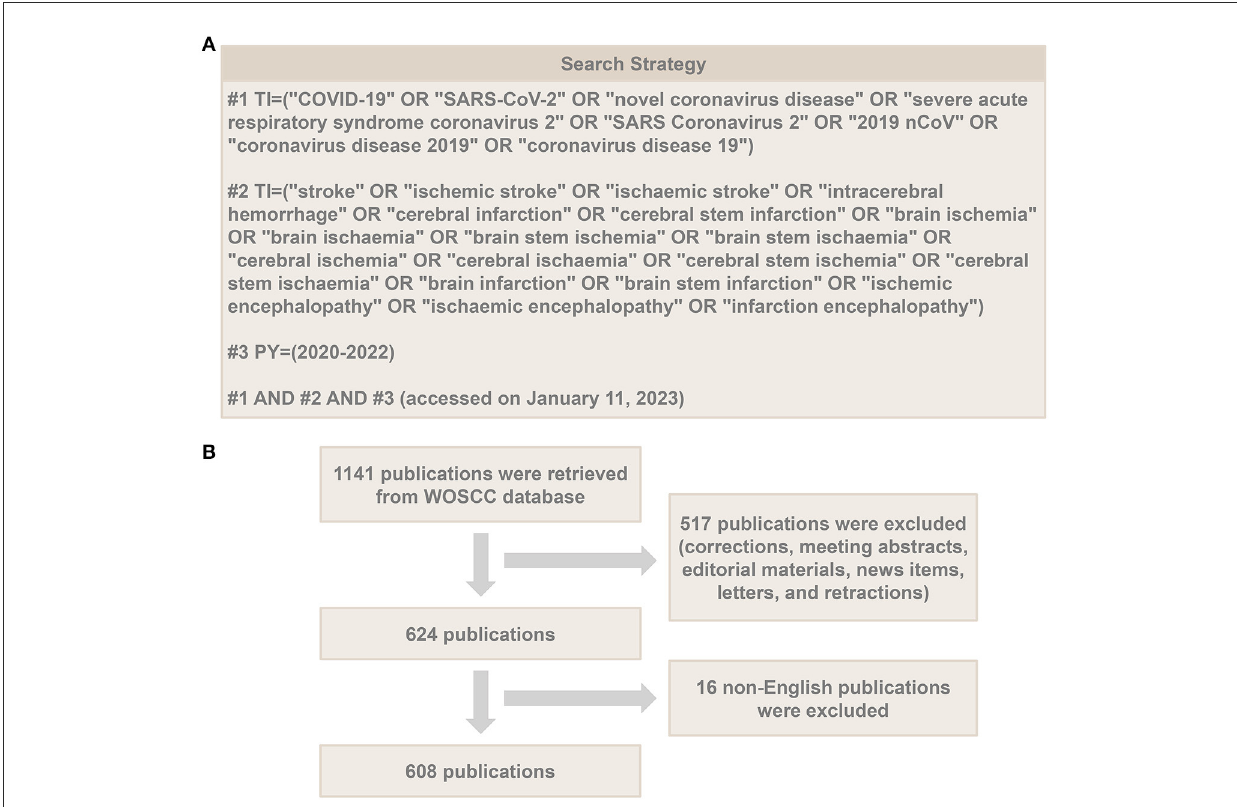
FIGURE1 The data collection process of this study. (A) Searching strategy; (B) screening